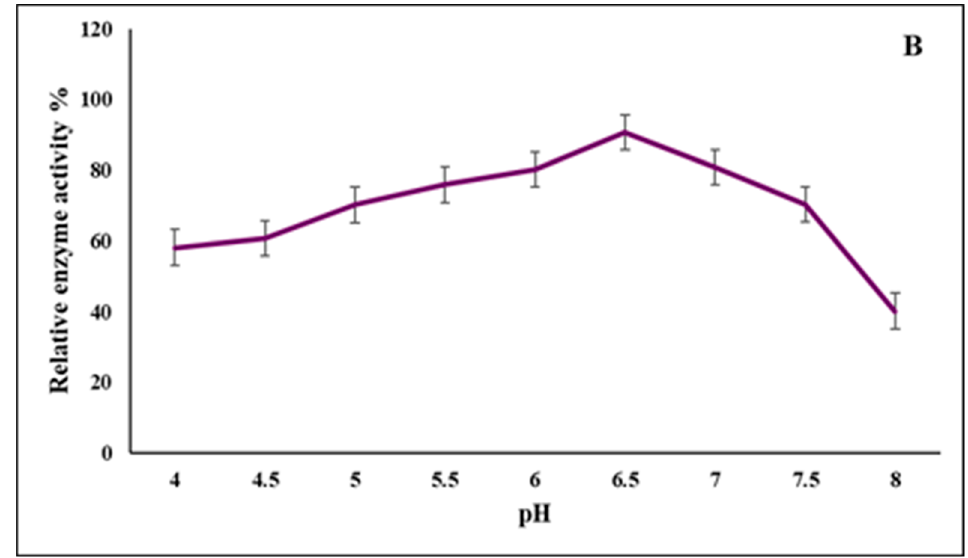
Figure 10. Effect of pH ( A ) and thermal stability ( B ) on the activity of purified chitinase on SSF by T. funiculosus strain CBS 129594. The values are the means of three replicates with standard deviation ( ± SD).